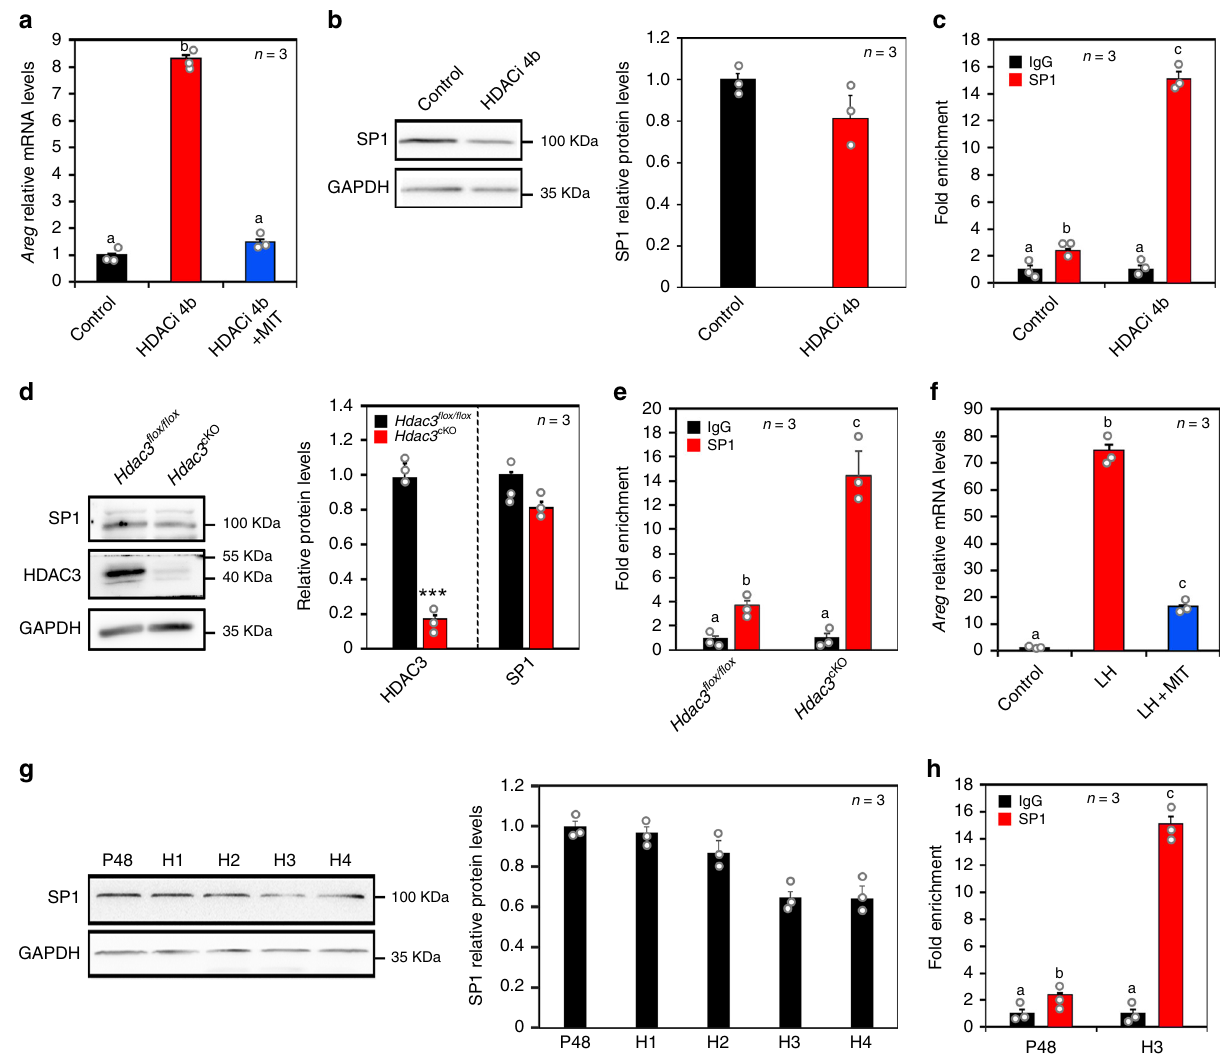
Fig. 5 HDAC3 and LH affected Areg expression by regulating SP1 recruitment to the Areg promoter. a Inhibition of SP1 reversed the HDACi 4b-mediated induction of Areg expression. MIT, SP1 inhibitor. Data are presented as mean ± SEM, and different letters (a – b) indicate signi fi cant differences among groups (two-sided ANOVA and Holm – Š idák test), P (a, b) < 0.001. b Western blotting analysis revealed that inhibition of HDAC3 did not affect SP1 expression. HDACi 4b, HDAC3 inhibitor. n = 3 biologically independent experiments. Data are presented as mean ± SEM. c ChIP-qPCR analysis of